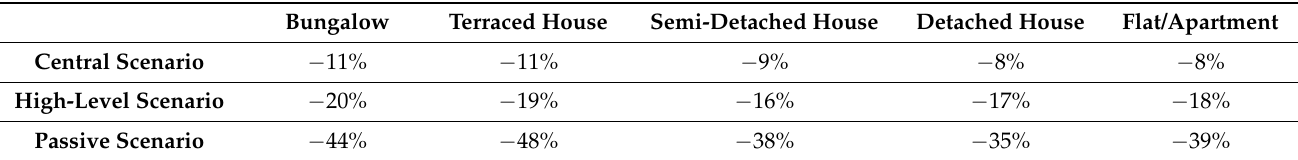
Table 9. Percentage demand reduction per retrofitted house